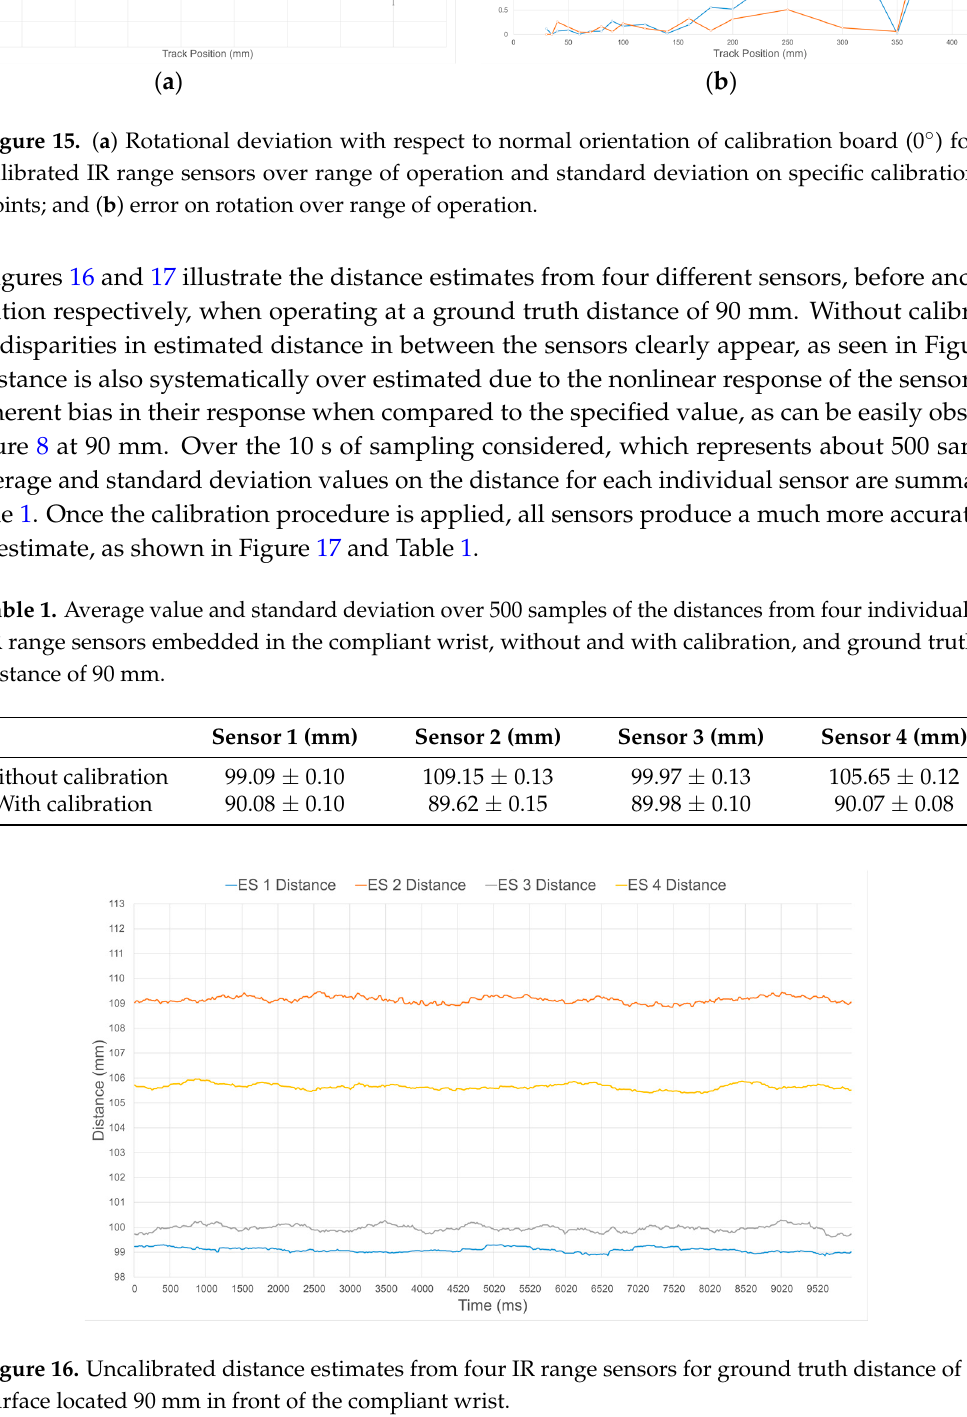
Figure 15. ( a ) Rotational deviation with respect to normal orientation of calibration board (0°) for calibrated IR range sensors over range of operation and standard deviation on specific calibration points; and ( b ) error on rotation over range of operation.